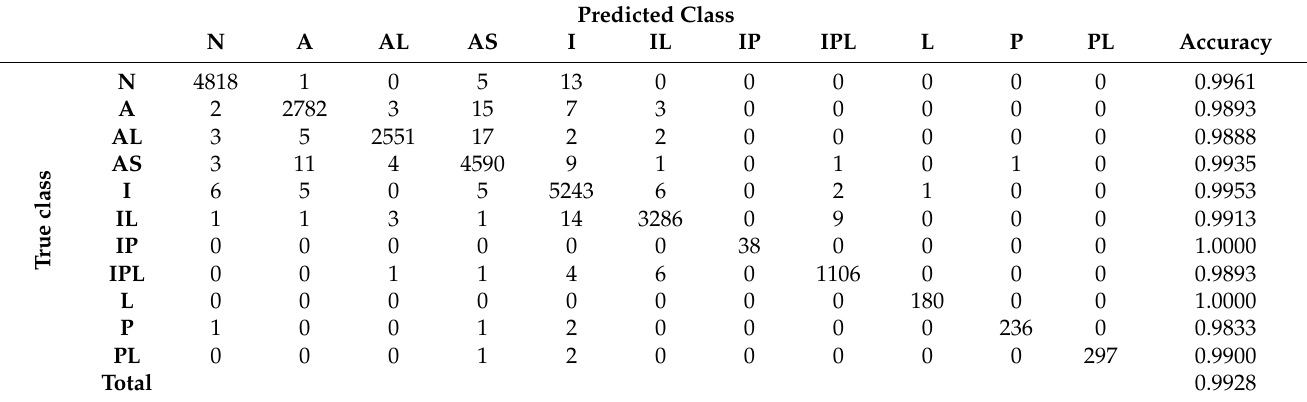
Table 5. Confusion matrix for MI localization and classification accuracy for each class in Setting